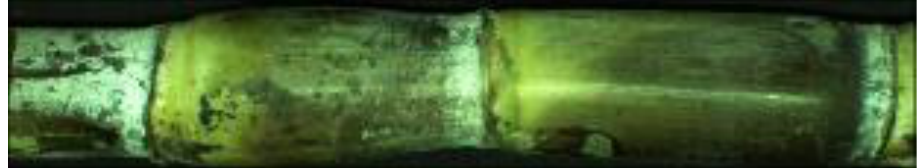
Figure 6. Image of the region of interest.